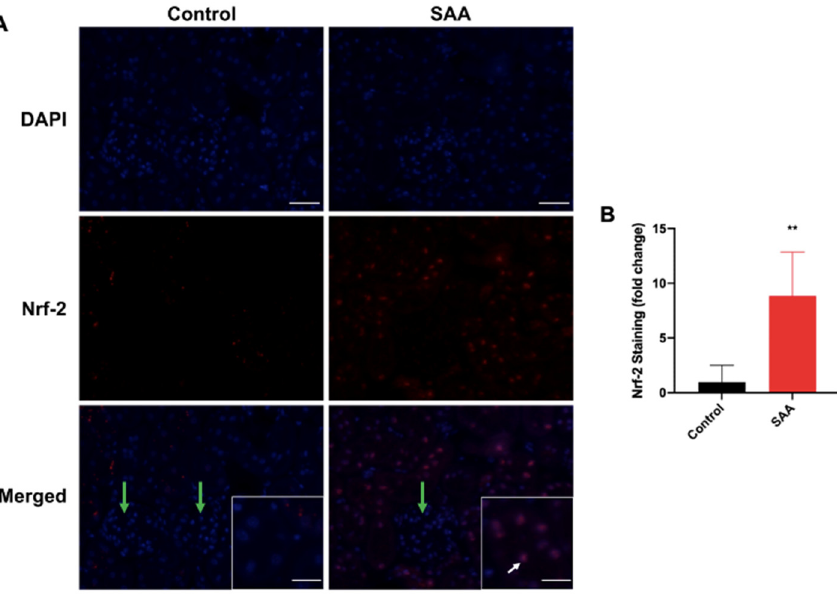
Figure 4. SAA administration stimulates Nrf2 expression in the renal cortical tissue. ( A ) Male ApoE − / − mice were randomly allocated to vehicle control (administered 100 µL PBS every 3 days for 2 weeks) and the SAA group (administered 12 µg SAA protein every 3 days for 2 weeks). Kidney tissue was harvested 4 weeks after cessation of treatment and fixed in situ before embedding and sectioning (5 µm). Renal sections were dewaxed and rehydrated before undergoing heat-induced antigen retrieval. Cortical Nrf2 expression was assessed using immunofluorescence microscopy. Slides were visualised at 40× magnification (scale bar = 20 µm); images are representative of at least 4 fields of view for each sample. Nuclei were stained with DAPI (blue) and Nrf2 with an appropriate Opal fluorophore (red). White arrows show regions of relatively high tubular Nrf2+ immunostaining. Green arrows show regions of relatively low glomerular Nrf2+ immunostaining. Insets show higher magnification images (scale bar = 10 µm), Nrf2+ staining was mixed with Nrf2 colocalised to nuclei with residual cytoplasmic staining. Representative images show cortical fields from n = 5 (Control), n = 6 (SAA). ( B ) Immunostaining was quantified using a mean staining intensity for each field of view and averaged for each sample. Data shown as relative mean ± SD. ** Relative to control group; p < 0.05.